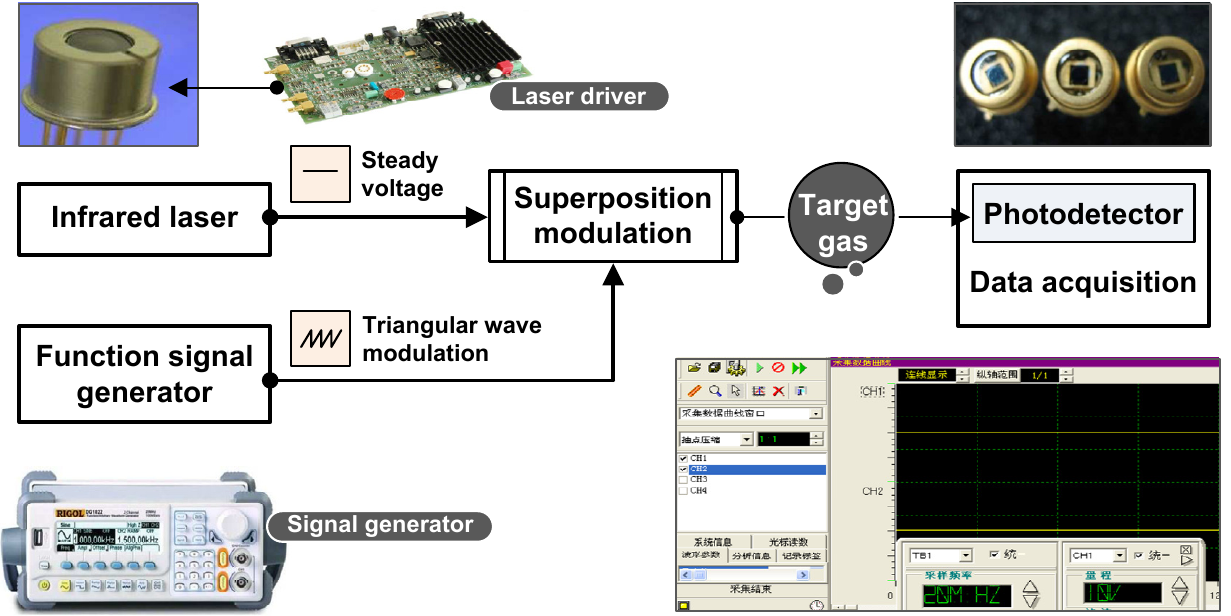
Figure 2. Schematic of the TDLAS system designed in the present work. Table 1. Main parameters of laser and function signal generator selected